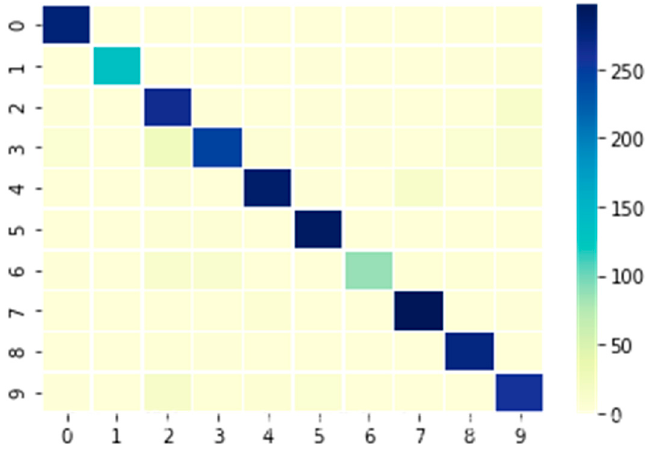
Figure 8. Model training results-confusion matrix.